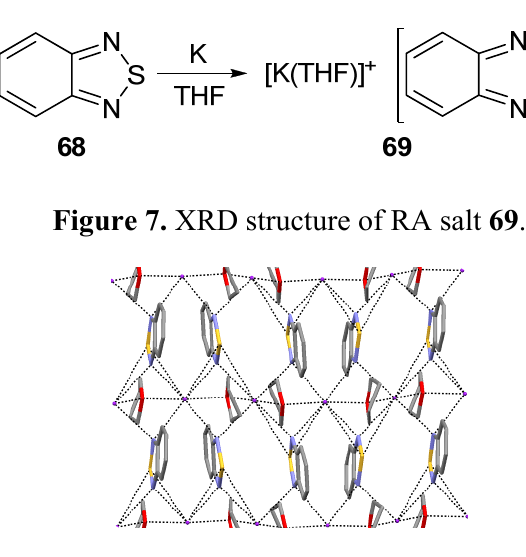
Scheme 34. Synthesis of homospin RA salt 69 .